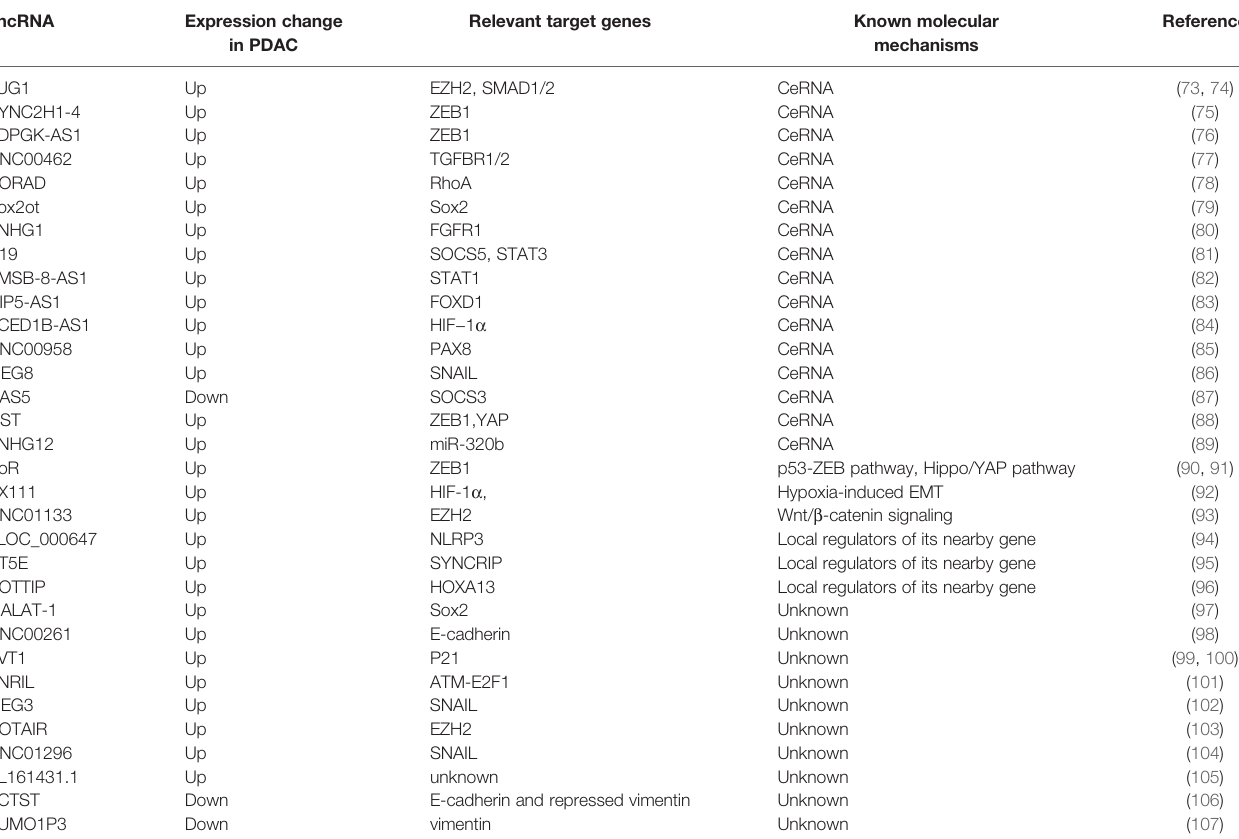
TABLE 1 | LncRNAs in PDAC development through EMT